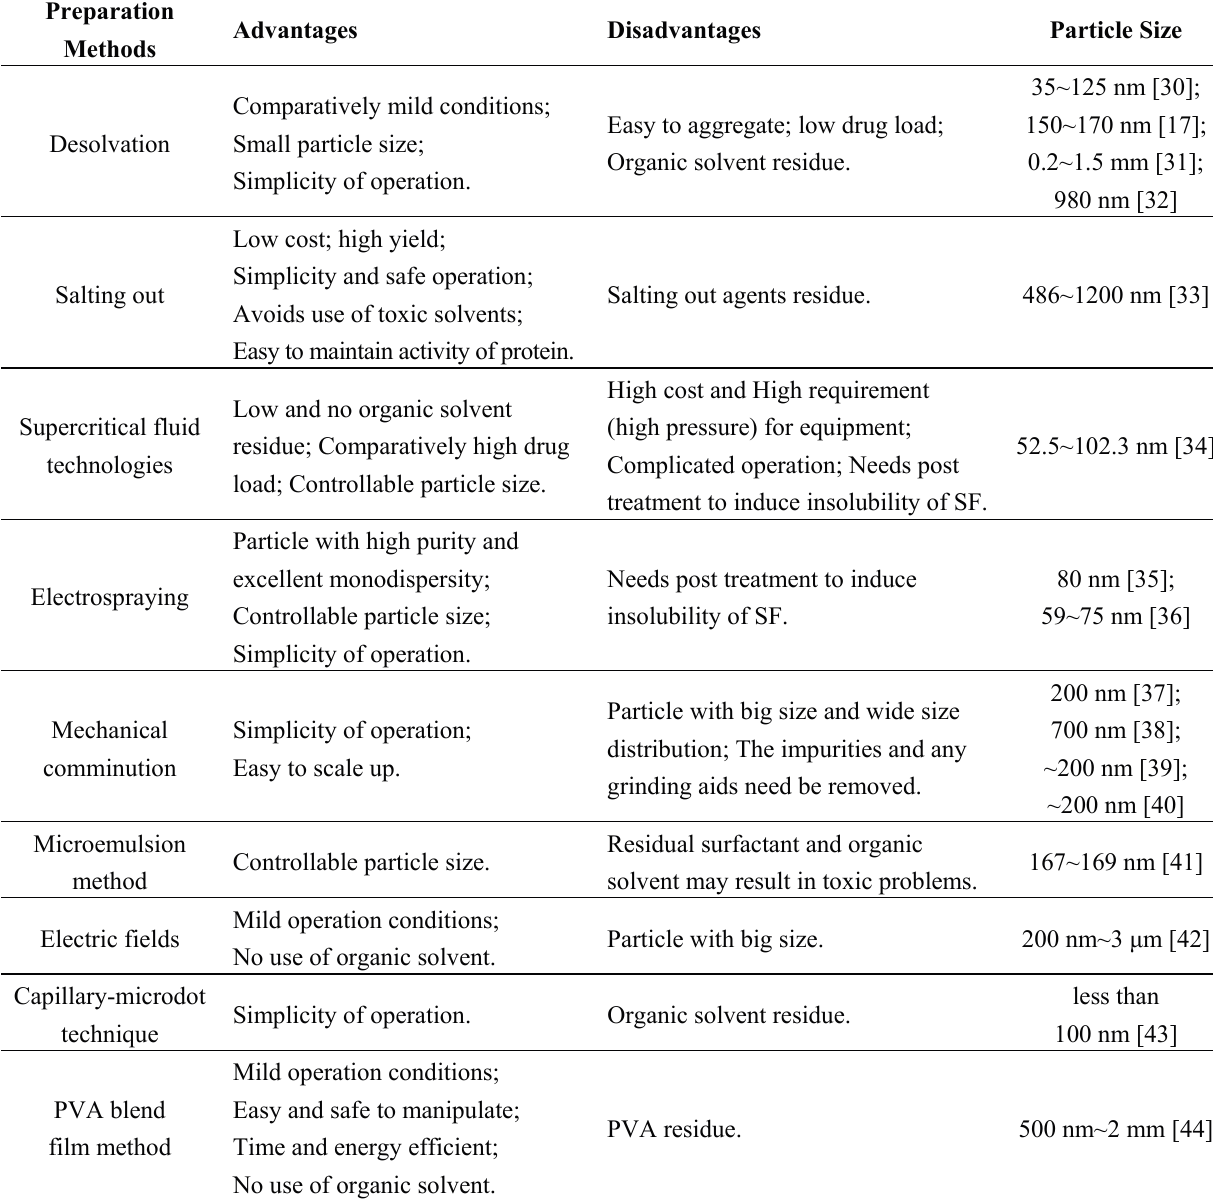
Table 1. The preparation methods of SF-based